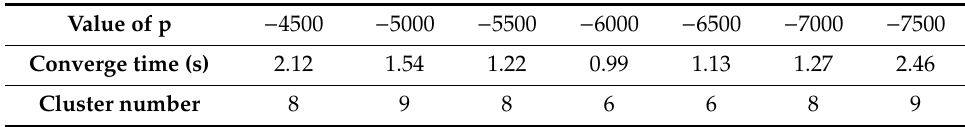
Table 3. Results of di ff erent values of p